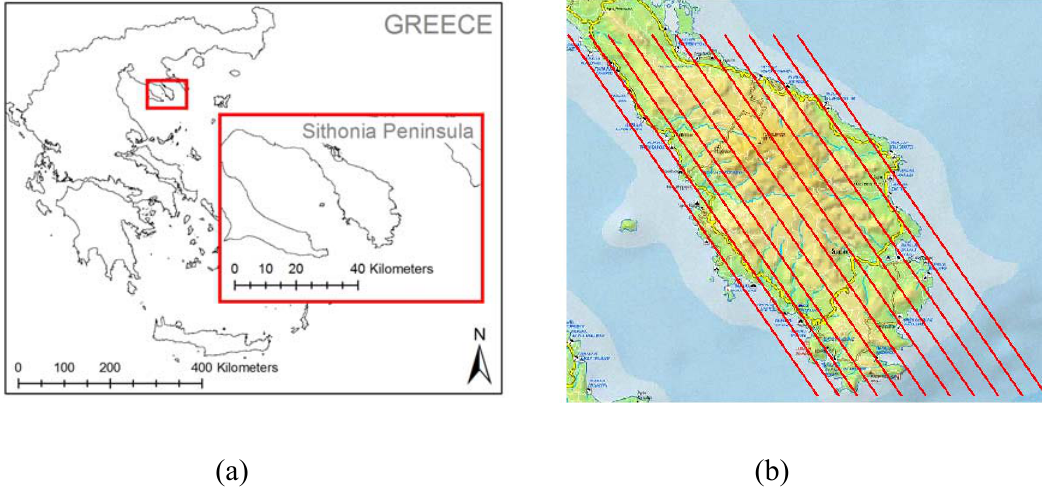
Figure 7 . (a) The Sithonia peninsula study area over which the SITHON system demonstrations were carried out. (b) Pre-designed navigation paths inserted to aircraft’s navigation control system for acquiring imagery with no gaps in terrain